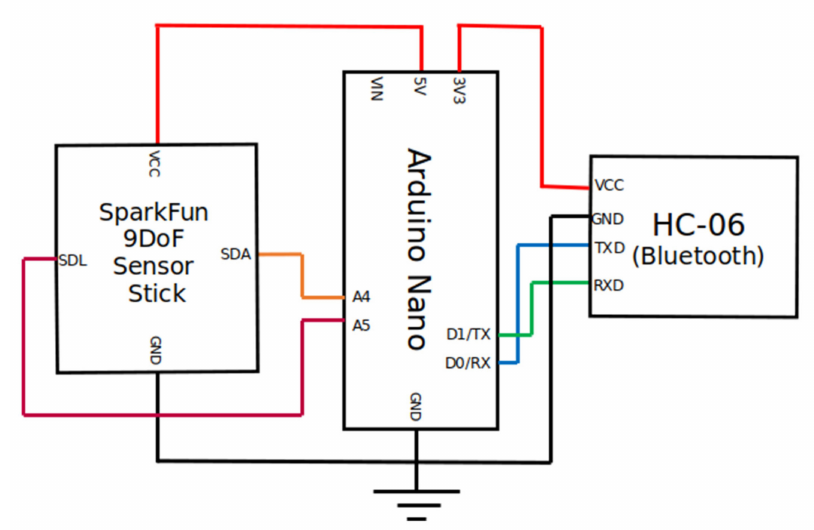
Scheme 1. Schematic block diagram of the interconnection between the device components. The Arduino Nano board (center) acts as the control and processing unit, collecting readings from the accelerometer (SparkFun block on the left), computing the estimations of the thigh angle over time, and analyzing the resulting signal. The Arduino Nano board also makes use of the Bluetooth module (HC-06 block on the right) to exchange messages with the external mobile device over a wireless communication channel. The whole device was powered by a 9V 6LP3146 battery. While the Arduino Nano board was directly powered by the battery, the accelerometer and the Bluetooth boards were indirectly powered by connecting them to the Arduino’s 5V and 3.3V DC outputs, respectively. The battery was omitted in this scheme for the sake of